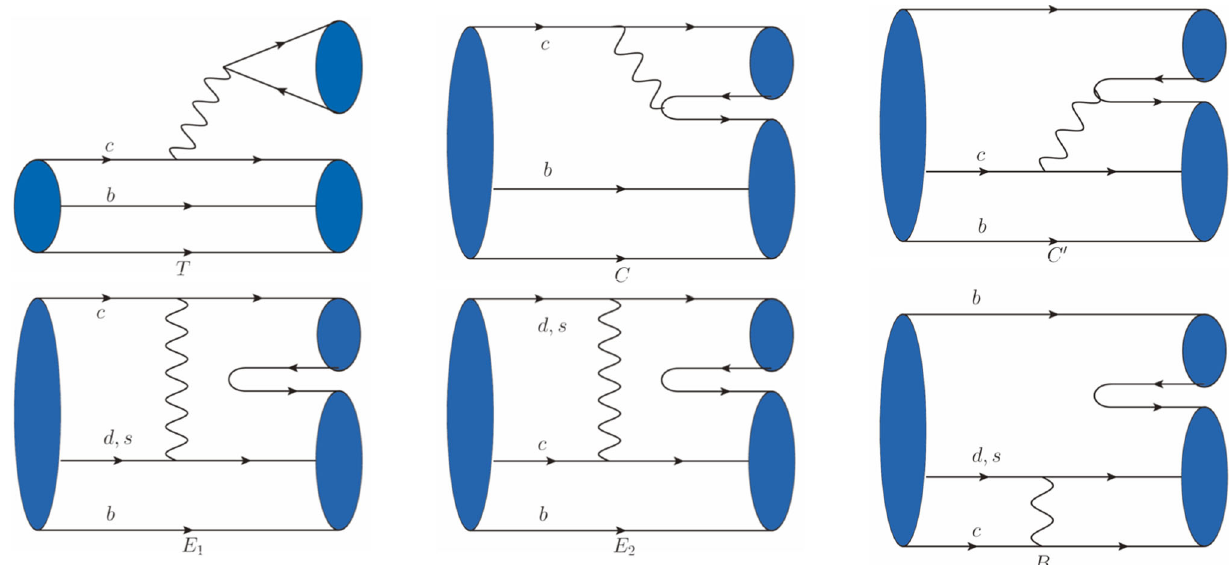
→ (cid:2) 0 π + at hadron level bc b